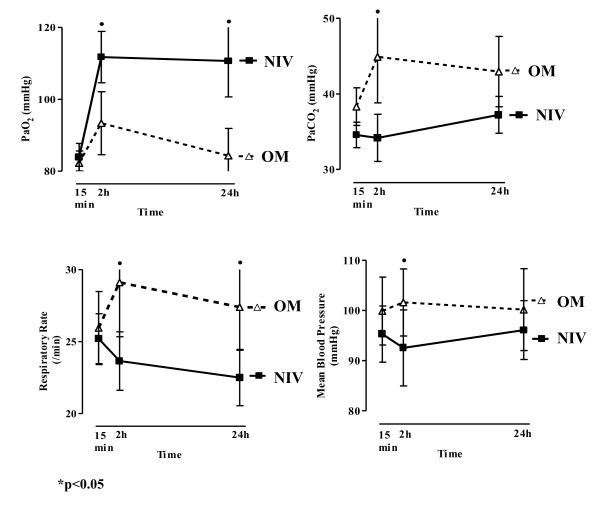
PaO2, PaCO2, RR, and mean arterial pressure profile for the NIV and OM groups at the three different time points (15 minutes, 2 hours, and 24 hours).